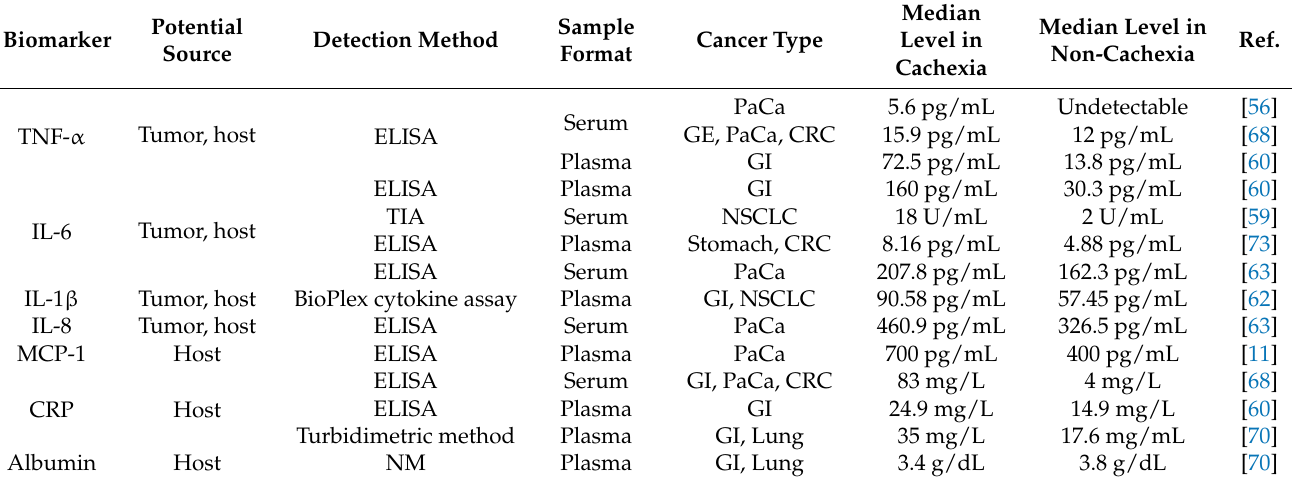
Table 2. Summary of inflammatory factors as potential biomarkers of cancer cachexia.